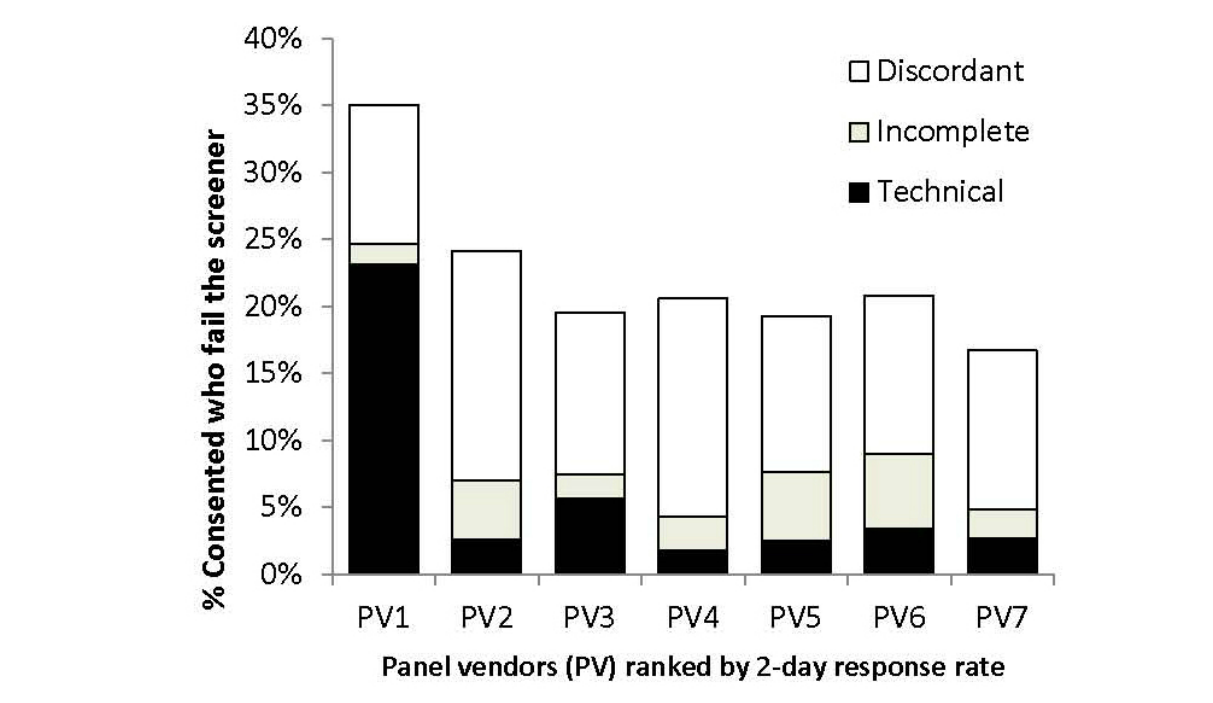
Figure 2. Proportion of consented respondents who failed the screener by reason and panel